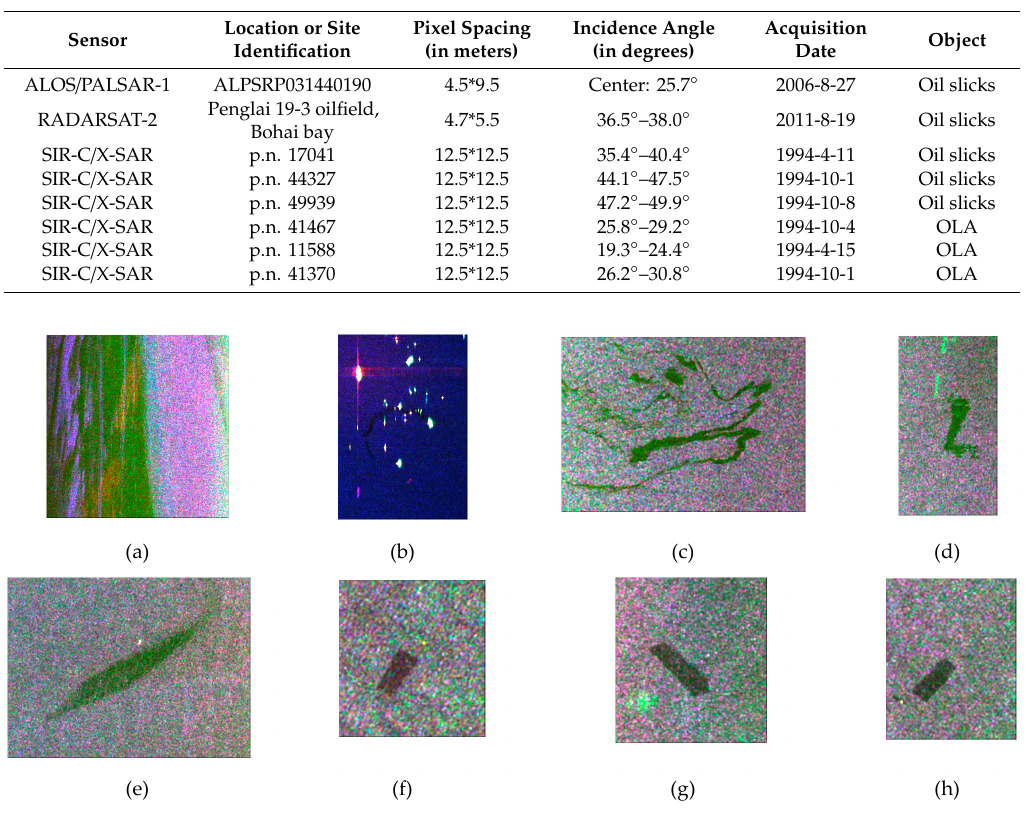
Table 1. Fully polarimetric synthetic aperture radar (SAR) images. The SIR-C/X-SAR data were measured in the C-band and p.n. is the processing number.